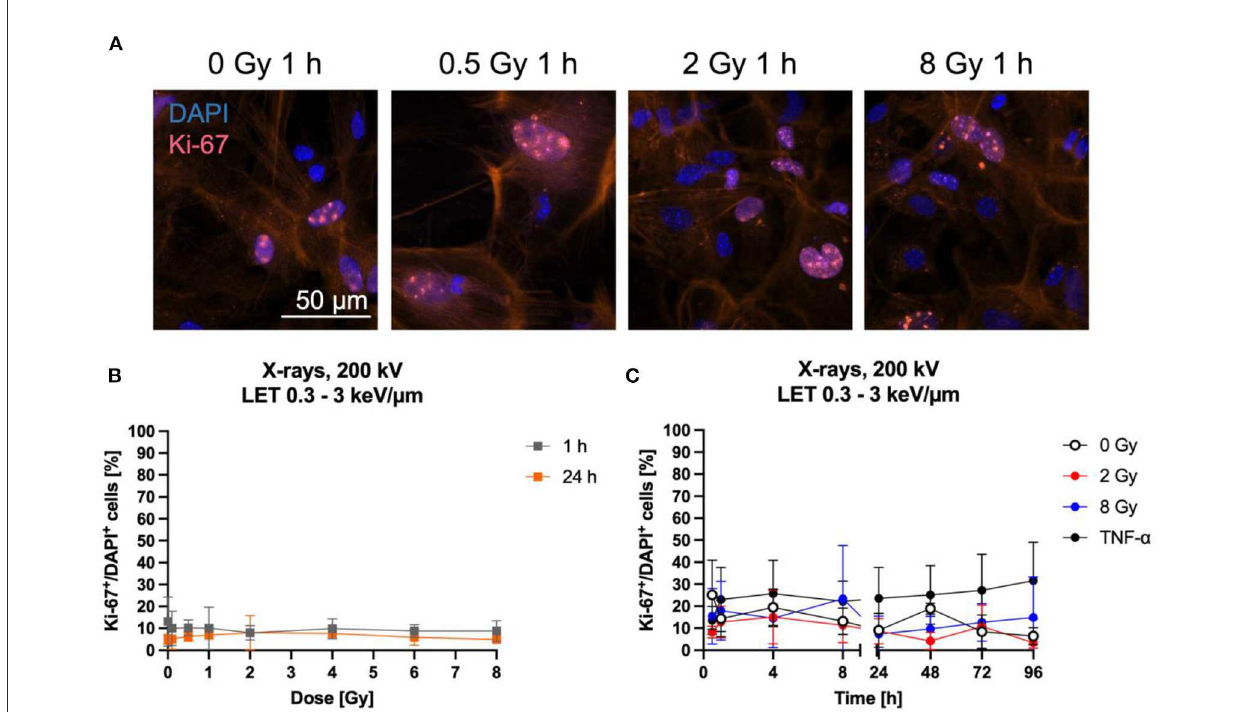
FIGURE6 Proliferation of astrocytes remained mainly unaffected by radiation exposure. Astrocytes were exposed to X-rays (200 kV, 15mA) with doses up to 8Gy and fixed for Ki-67 immunostaining after different time points. Ki-67 is an indicator of proliferating cells. (A) Exemplary images of Ki-67 (pink) immunostaining showing an unirradiated control and cells 1h after exposure to different doses of X-rays. The nucleus was stained with DAPI (blue) for all images, resulting in blue (Ki-67 negative) or blueish-pink cell nuclei with pink Ki-67 spots (Ki-67 positive, Ki-67 + ). The red fluorescence in the cytoplasm is due to phalloidin-647 staining of actin. Bar: 50 µ m. (B, C) Quantitative evaluation of the Ki-67 + DAPI + cells after exposure of astrocytes to X-rays. (B) Dose effect curves of Ki-67 + cells 1h and 24h after exposure to X-rays ( n = 4). (C) Kinetics of Ki-67 + cells up to 96h after exposure to X-rays. TNF- α was added to unirradiated samples at the time of irradiation at a concentration of 20ng/ml as it was previously described to stimulate proliferation of astrocytes. The percentage of Ki-67 + cells remained mainly unaffected by irradiation with different doses of X-rays over a time period of 1h to 96h. The samples were compared via one-way ANOVA, based on a sample size n = 4 ( p < 0.05). Data are shown as mean ±